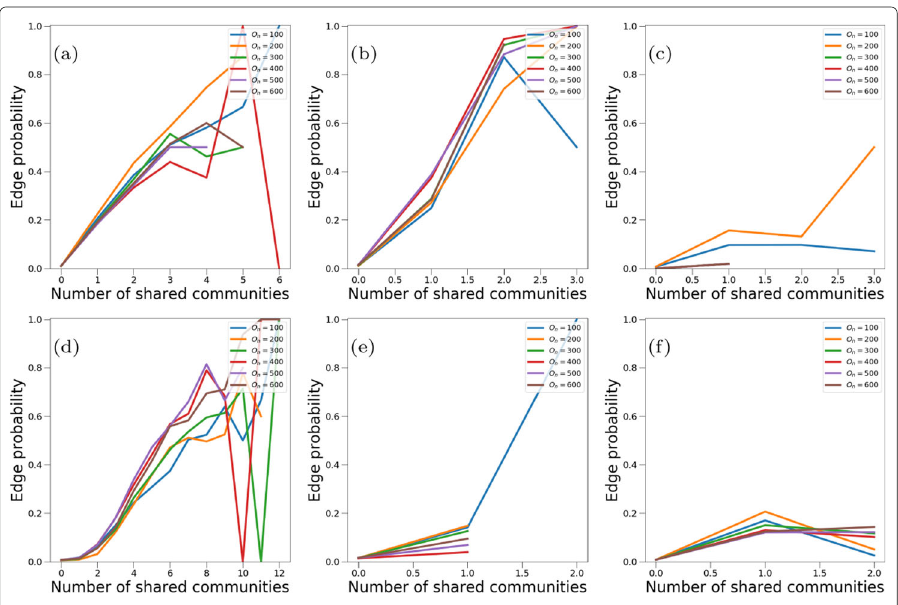
Fig. 27 Variation of the number of nodes in the overlapping region ( O n ) for LFR synthetic networks considering the edge probability: a Bigclam; b CFinder; c Copra; d Demon; e SLPA; f Ground-Truth